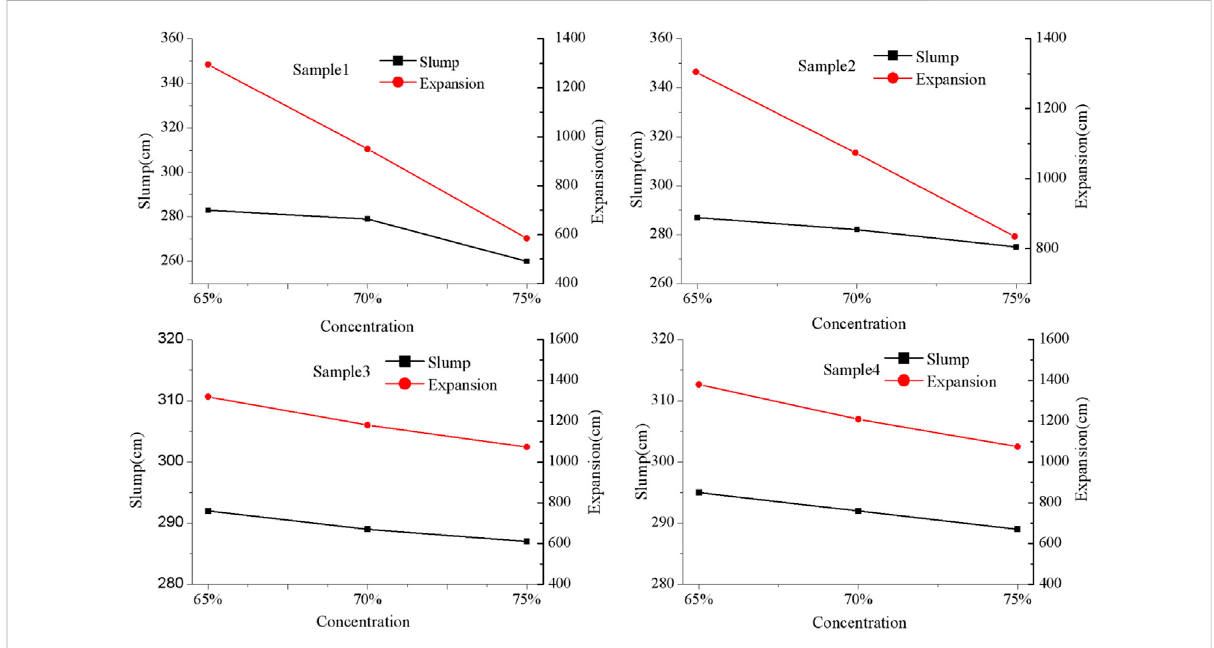
FIGURE 6 Slump test results of gangue slurry.